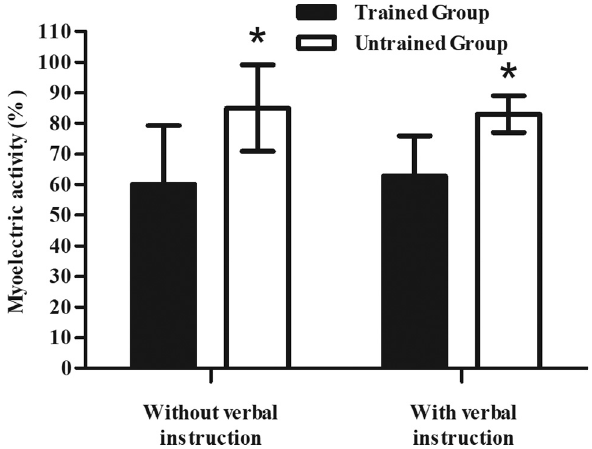
Figure 2 - Myoelectric activity of the teres major muscle during the seated row at 70% 1RM with and without verbal instructions in trained and untrained group. (* indicates bigger than trained group, p < 0.05).